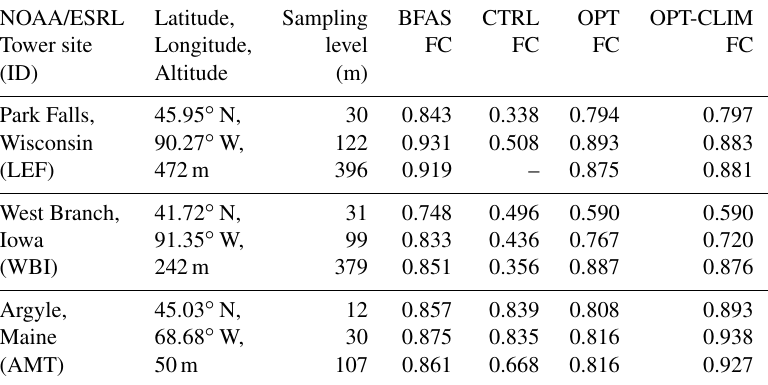
Table 4. Correlation coefficient of different forecast (FC) experiments (see Table 2) with observations at three NOAA/ESRL tall towers for daily mean dry molar fraction of atmospheric CO 2 in March 2010. The dash symbol means the correlation is not significant. NOAA/ESRL Latitude, Sampling BFAS CTRL OPT Tower site Longitude,